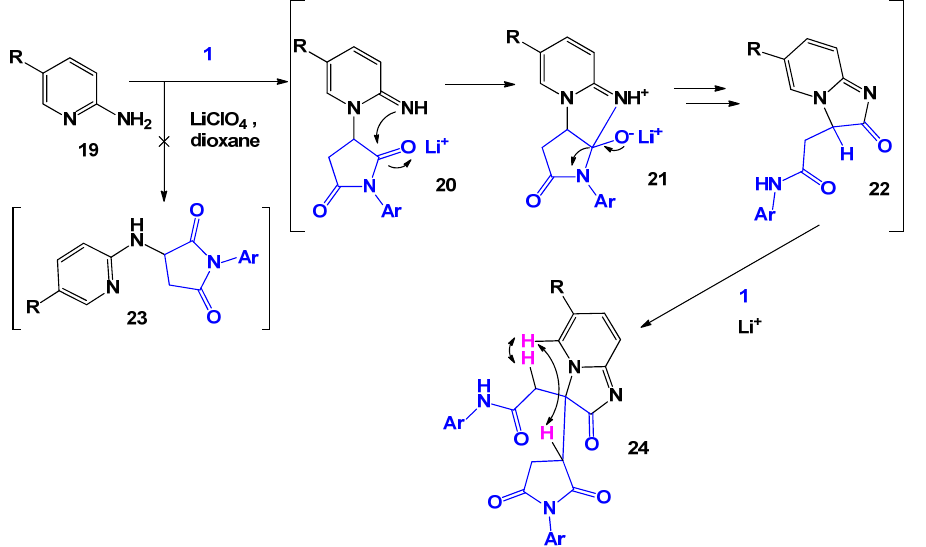
Table 1. The composition of the reaction masses.